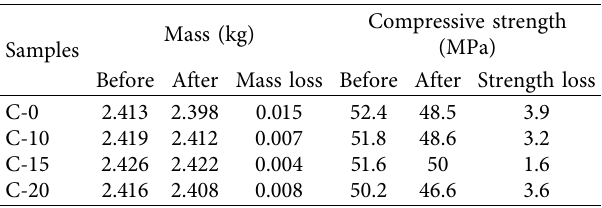
Table 7: The weight and strength loss of concrete after freezing and thawing.